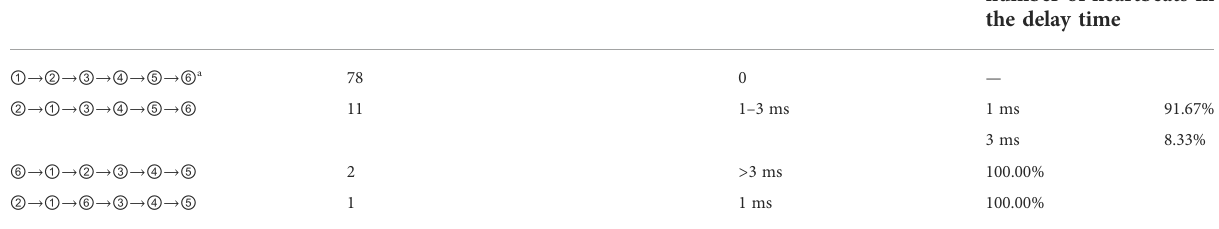
TABLE 2 Statistics for the excitement sequence of sinus rhythm.